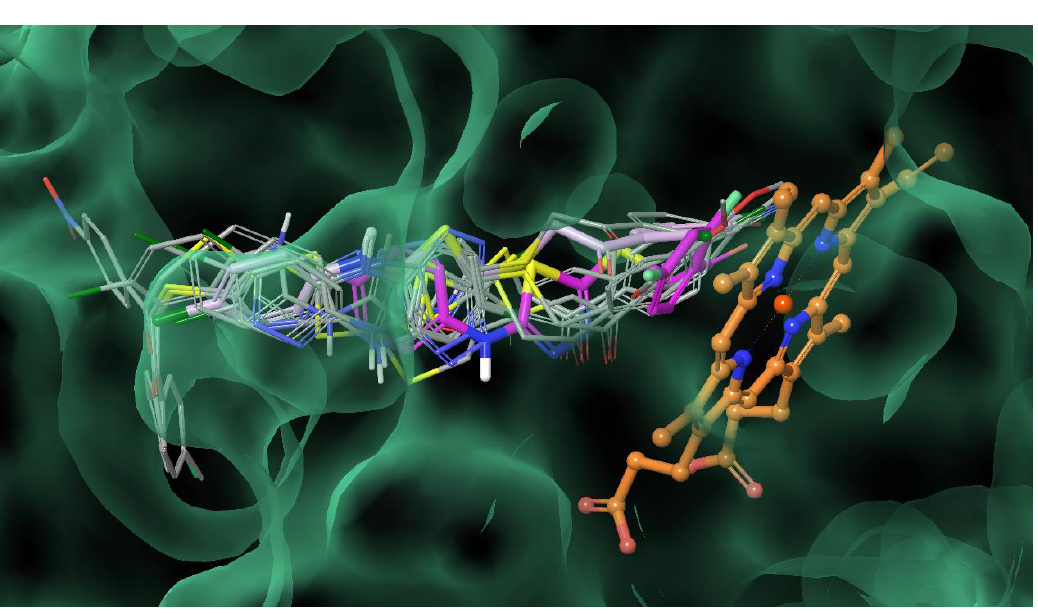
Figure 4. Active compound 3k in the active region of 14- α -sterol demethylase (PDB code: 5FSA). The inhibitor is colored purpl,e and the heme molecule is colored orange.